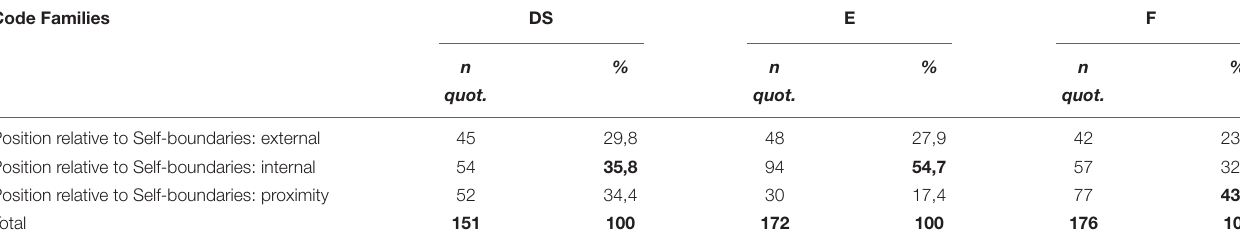
TABLE 8 | Frequency distribution of indicators of the position relative to Self-boundaries in the AAI groups. Code